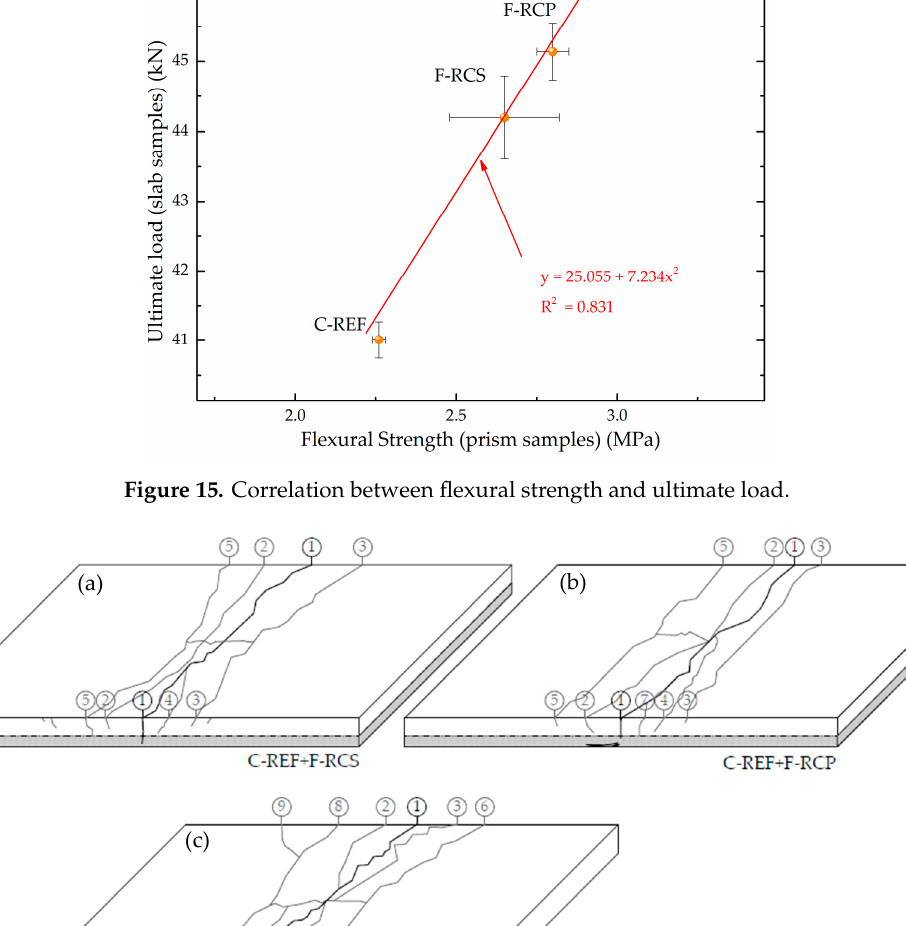
Figure 16. Scheme of crack development in the final testing phase of the slabs ( a ) C-REF + F-RCS slab; ( b ) C-REF + F-RCP slab; ( c ) C-REF slab.